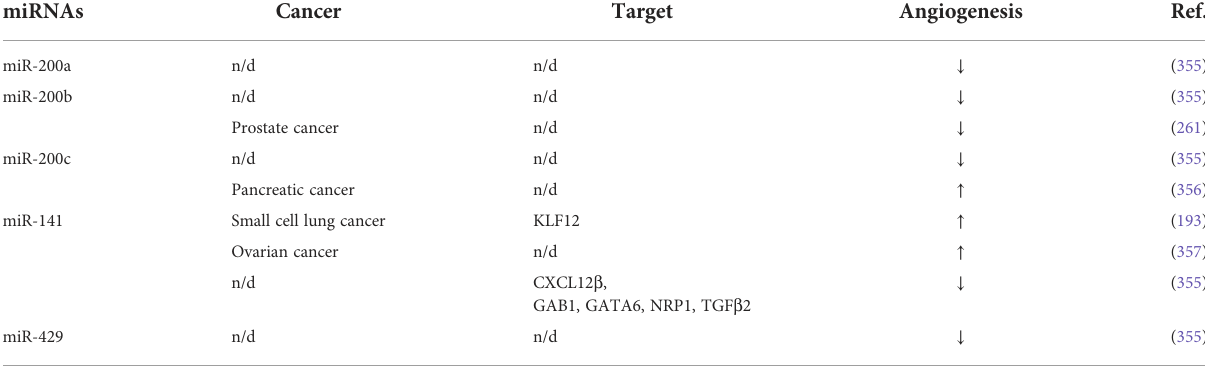
TABLE 6 Regulation of angiogenesis by miR-200 family